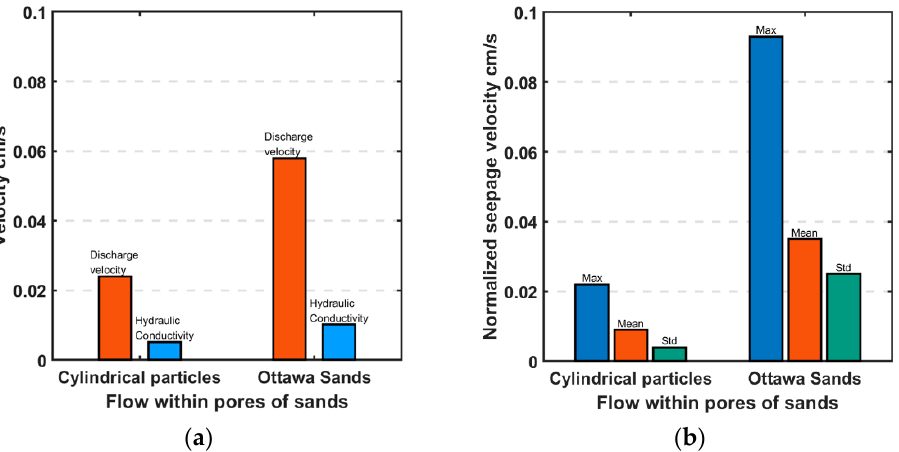
Figure 14. Comparison of hydraulic conductivities (velocity v, normalized by hydraulic gradient, i) between Cylindrical particles and simulated Ottawa sand particles. ( a ) Discharge velocity, and ( b ) Seepage velocity.